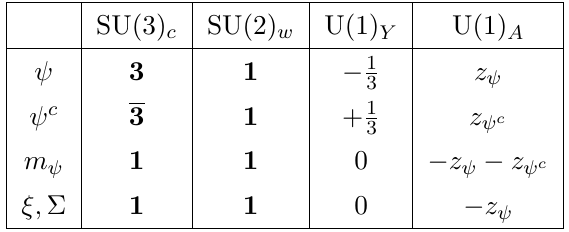
Table 1 . Field content beyond the SM in the minimal Nelson-Barr model. All fields are Weyl fermions. The U(1) A symmetry is